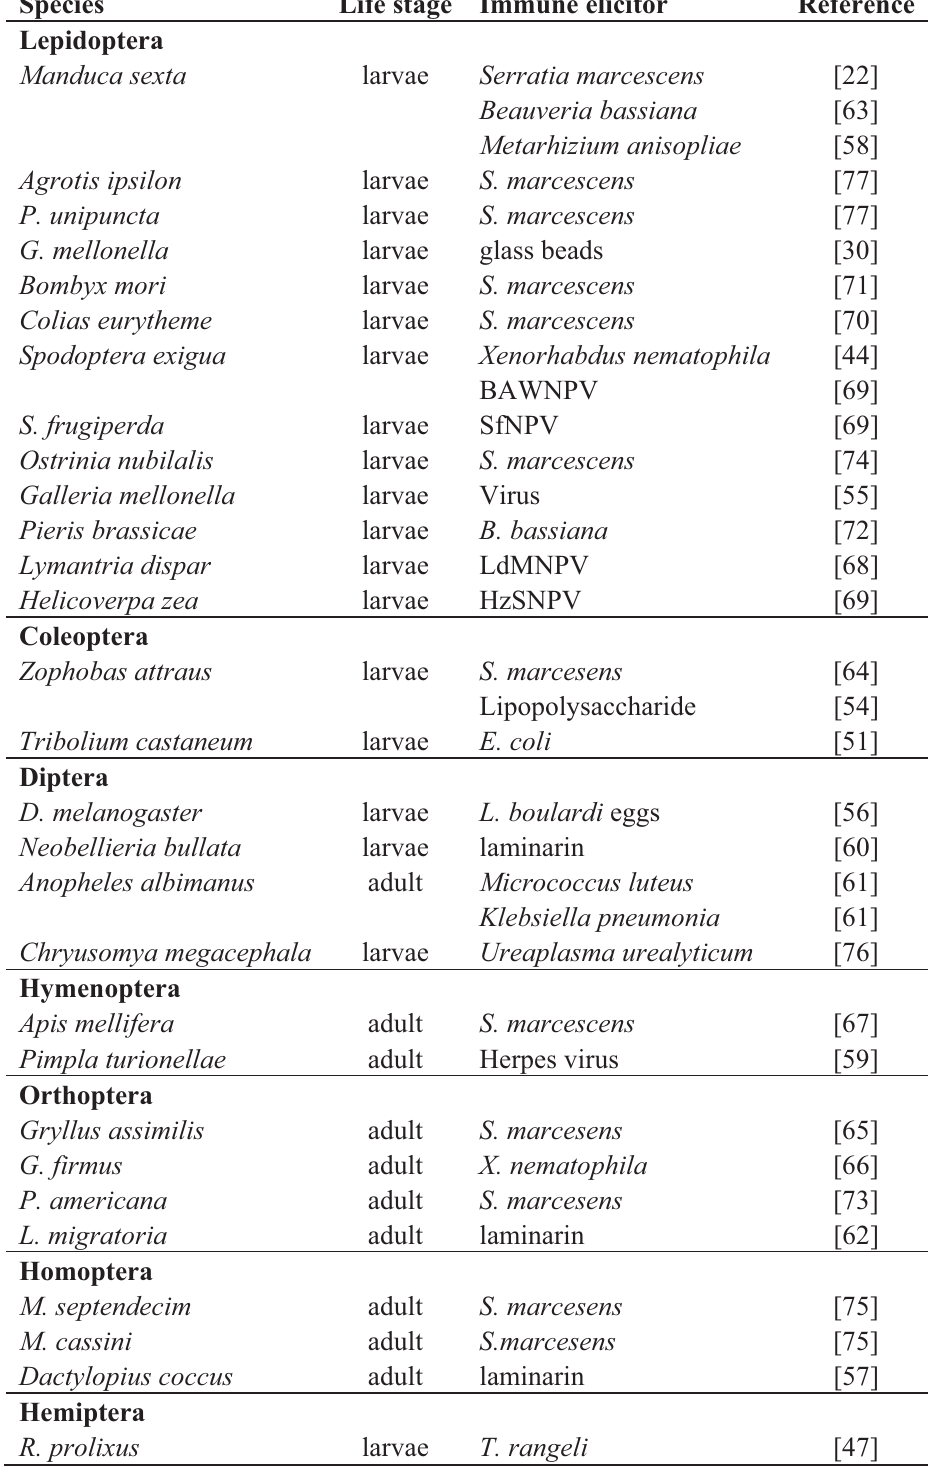
Table 1. Eicosanoids mediate cellular immune reactions to immune challenge in juvenile and adult representatives of seven insect